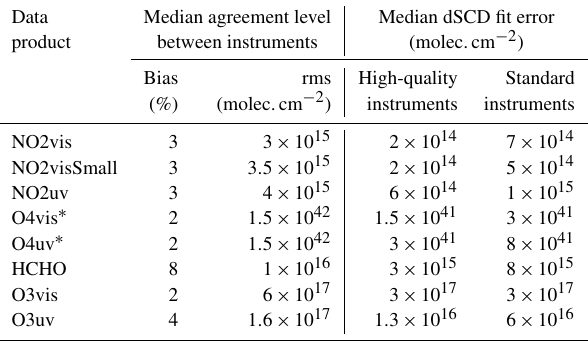
Table 7. Summary of the level of agreement obtained for dSCD measurements during CINDI-2 and typical uncertainties achieved by high-quality and standard instruments for the different data prod-